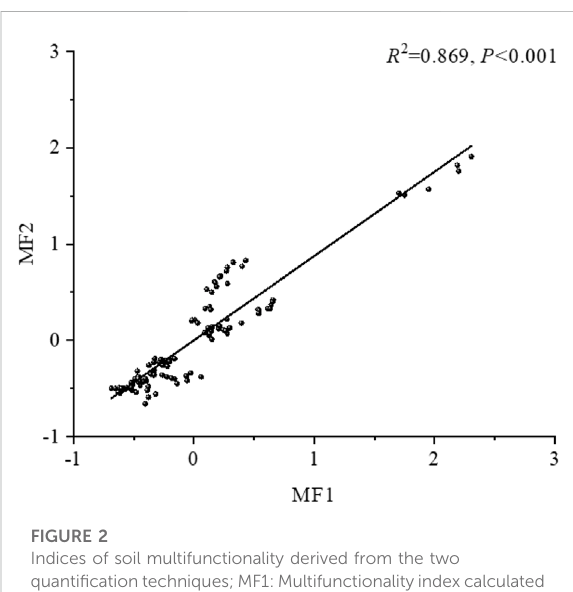
FIGURE 2 Indices of soil multifunctionality derived from the two quanti fi cationtechniques;MF1:Multifunctionalityindexcalculated using the average approach; MF2: Multifunctionality index calculated using the factor analysis